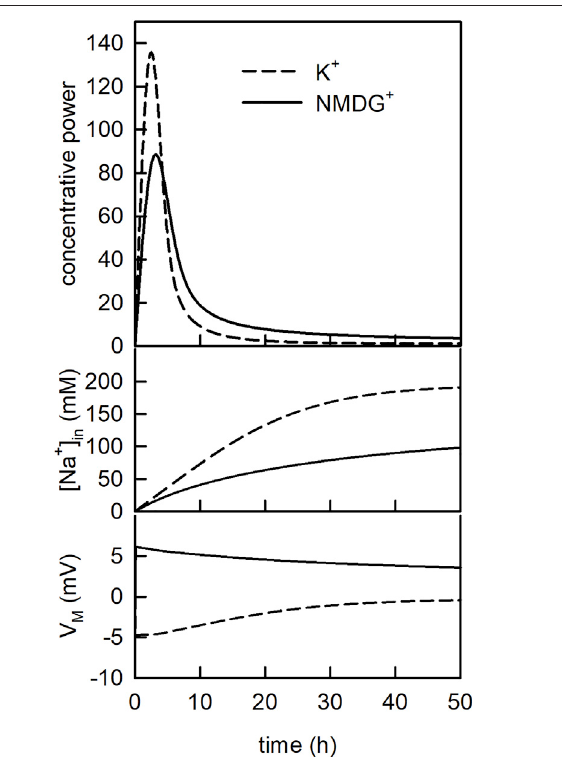
FIGURE 5 | The concentrative power of SGLT1 changes over time. Upper panel Evolution of the concentrative power of SGLT1 over time. In the simulation 1 µM glucose was applied for 50 h. The dashed line and the solid lineshowthe concentrative power ([Glu] in /[Glu] out ) inthepresence and in the absence of the K + gradient, respectively. Middle panel Time course of the intraluminal sodium concentration [Na + ] in for the two conditions. Lower panel Time course of the membrane voltage ( V M ) for the two glucose uptake by SGLT1 we know that this cannot be due to K + antiport. In Figure 4 (upper panel), we simulated glucose uptake into the vesicle for a period of 100 s on addition of 1 µM glucose to the extra-vesicular solution. We note that 1 µM is within the range of concentrations, which are typically employed in radioligand uptake assays. As seen, in the presence of the K + gradient, uptake of glucose into the vesicle was increased. In Figure 4 (upper middle panel) we plotted the evolution of V M over time for the two experimental conditions. The plot con fi rmed that the observed